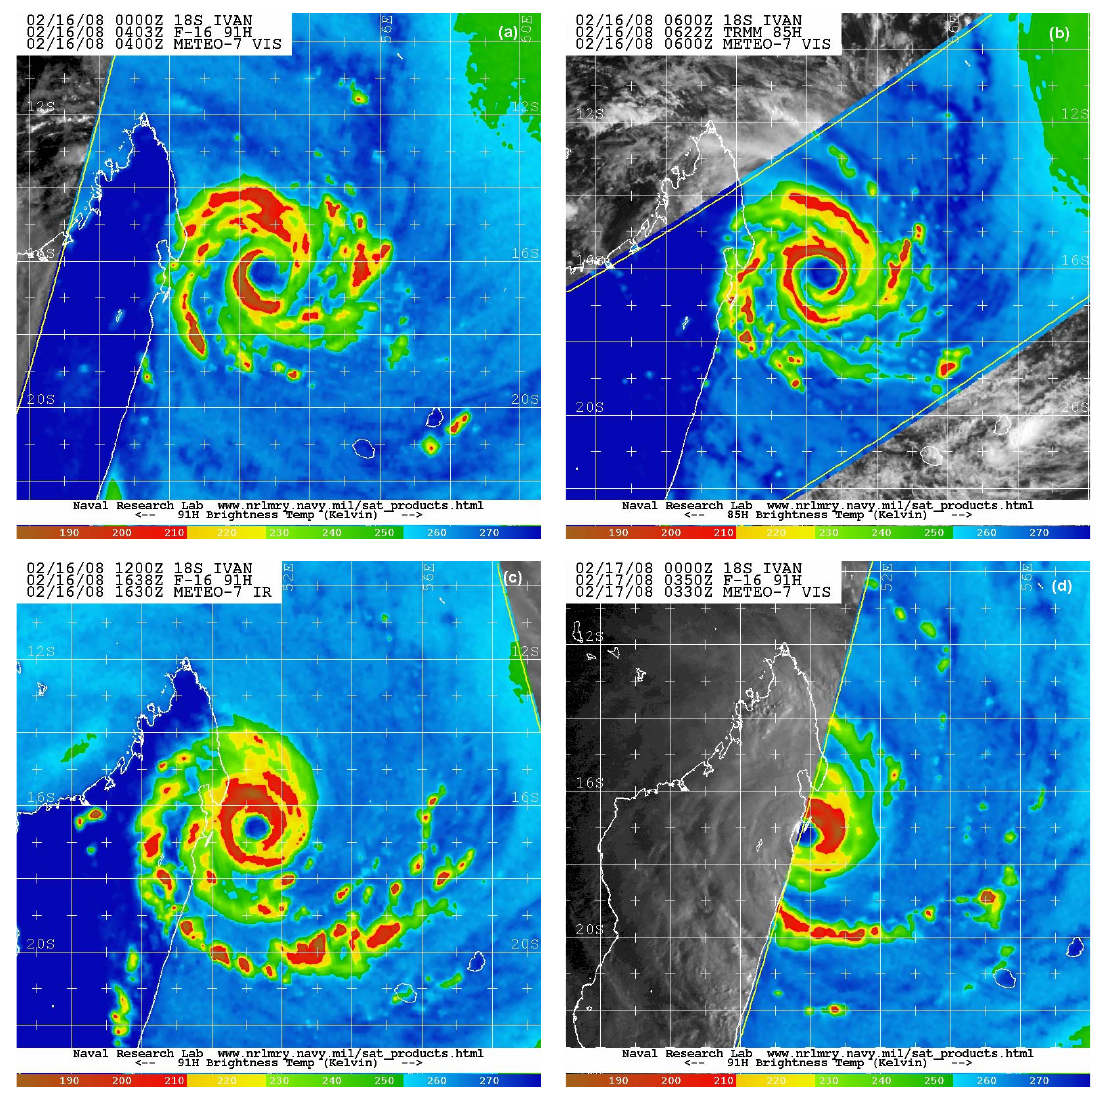
Fig. 1. METEOSAT7 visible images of TC Ivan with (a) F-16 SSMI/S brightness temperatures on 16 February 2008 at 00:00UTC. (b) TRMM TMI brightness temperatures at 85H on 16 February 2008 at 06:00UTC. (c) F-16 SSMI/S brightness temperatures on 16 February 2008 at 16:30UTC. (d) F-16 SSMI/S brightness temperatures on 17 February 2008 at 00:00UTC (from http://www.nrlmry.navy.mil/tc_